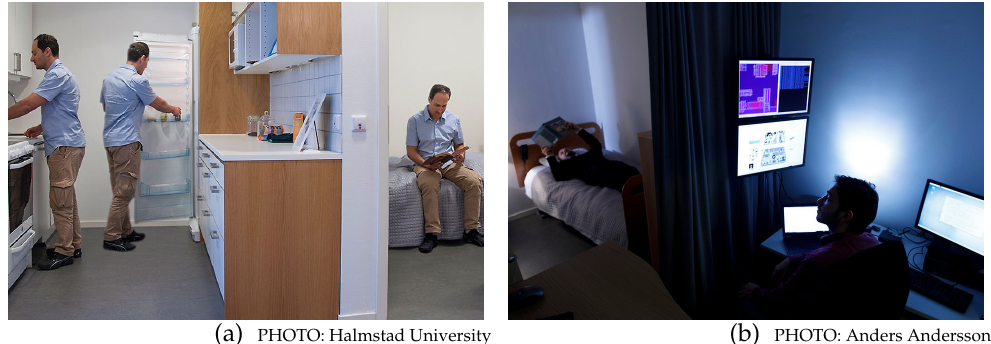
Figure 2. ( a ) A participant undertaking some of the ADLs in the kitchen and bedroom. ( b ) Human behaviour monitoring at